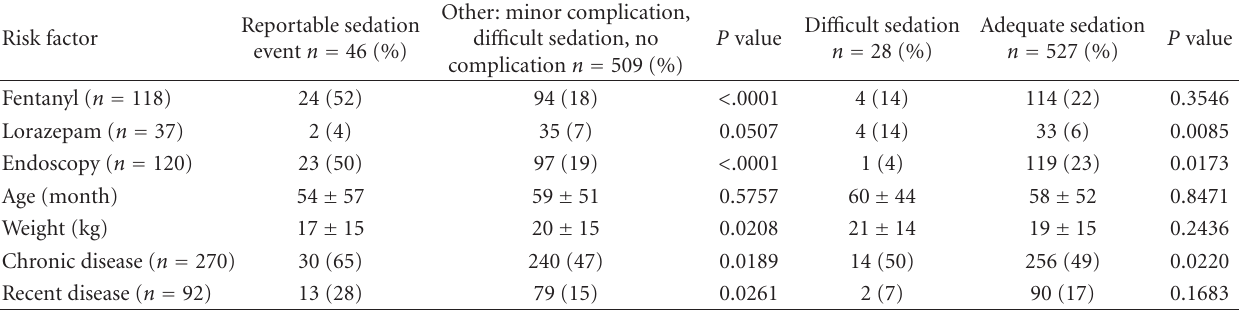
Table 2: Association test between risk factors: P values were calculated using χ 2 analysis.